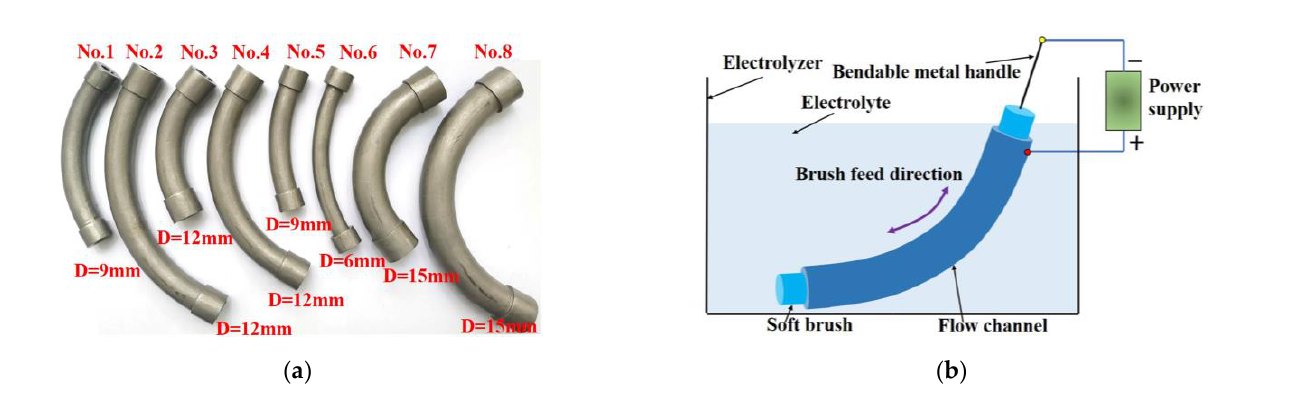
Figure 3. Experiment preparation: ( a ) flow channel samples fabricated using selective laser melting (SLM); ( b ) electrochemical polishing schematic.